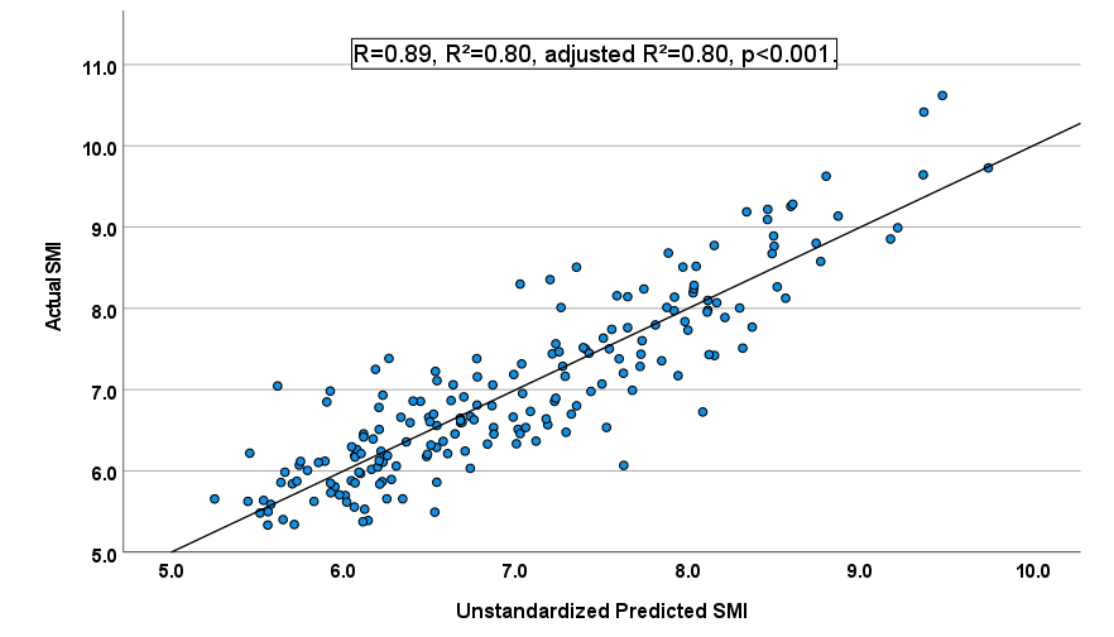
Figure 3. Actual SMI and unstandardized predicted SMI plots calculated by the stepwise multiple regression analysis.